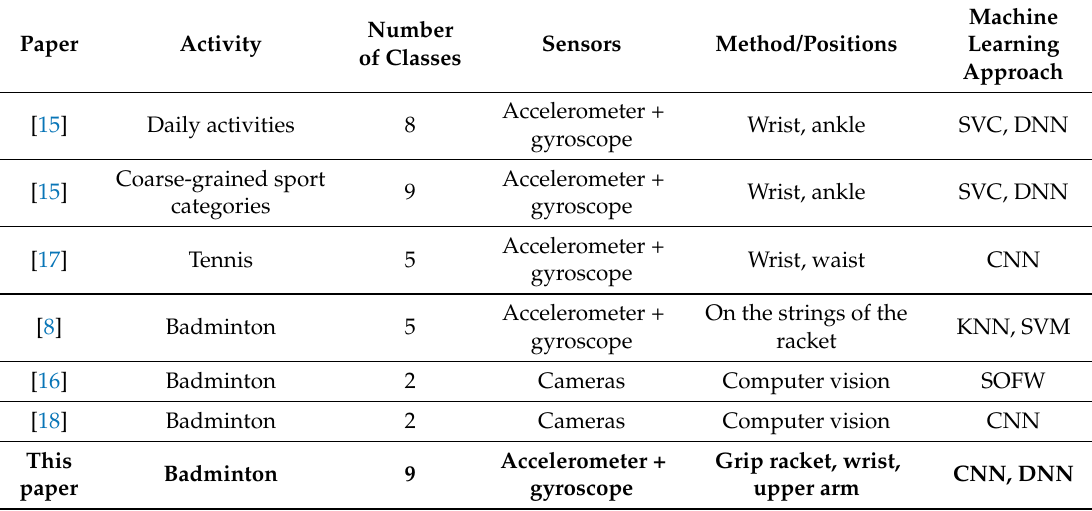
Table 1. Comparing recognized activities, number of distinguished classes, sensors, and